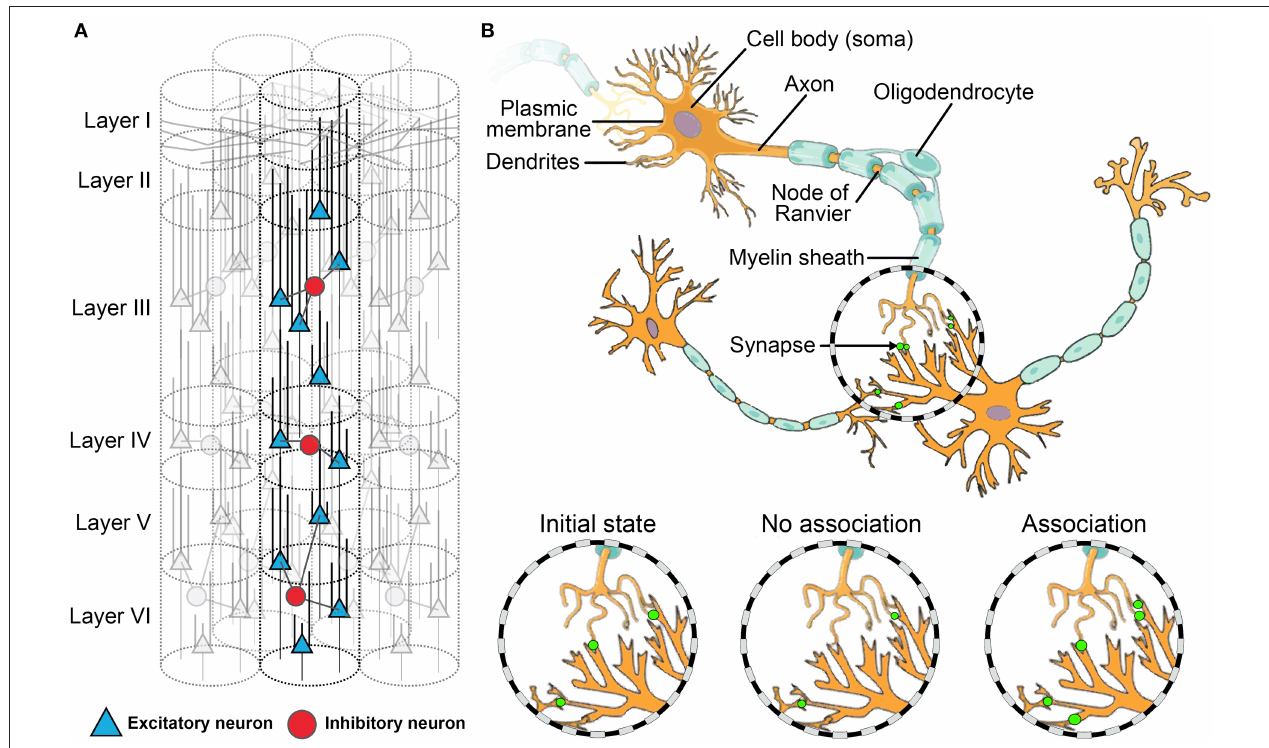
FIGURE 2 | Neural connectivity and plasticity at the meso- and micro-scale levels. (A) A cortical macro-column composed of multiple mini-columns. Those ensembles of 80–100 cells across cortical layers form the basic micro-circuit of the brain at the intermediate level between the anatomic and synaptic levels. (B) A small network of excitatory neurons (synapses in green). The figure illustrates synaptic plasticity. At the initial state, there are already some synapses. After learning, those existing synapses decrease in size or disappear if there is no association between pre- and post-synaptic neural activity; conversely, if there is an association, the existing synapses increase in size and additional synapses can even